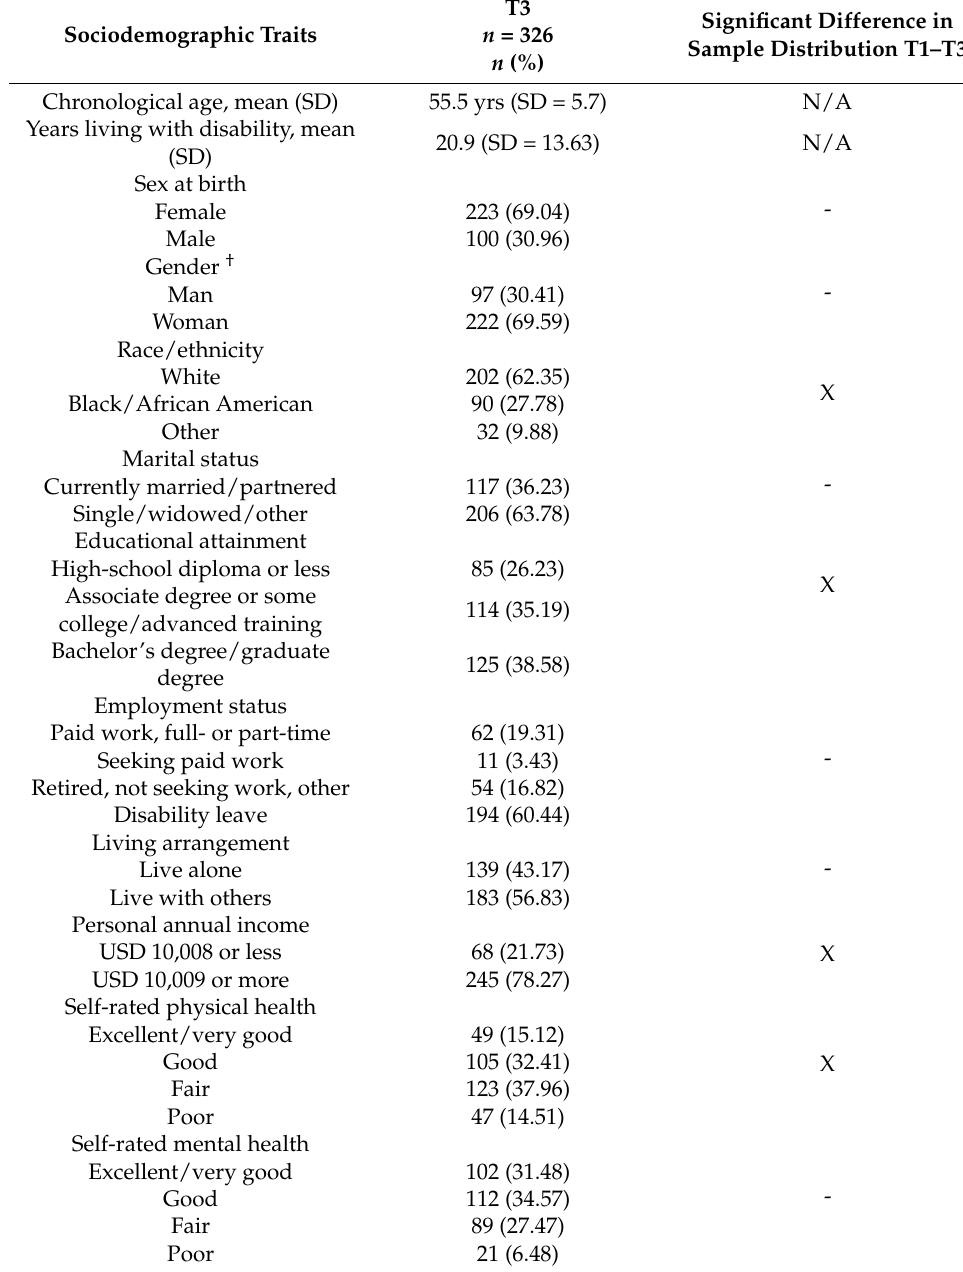
Table 1. Sociodemographic traits of T3 participants with sample differences from T1